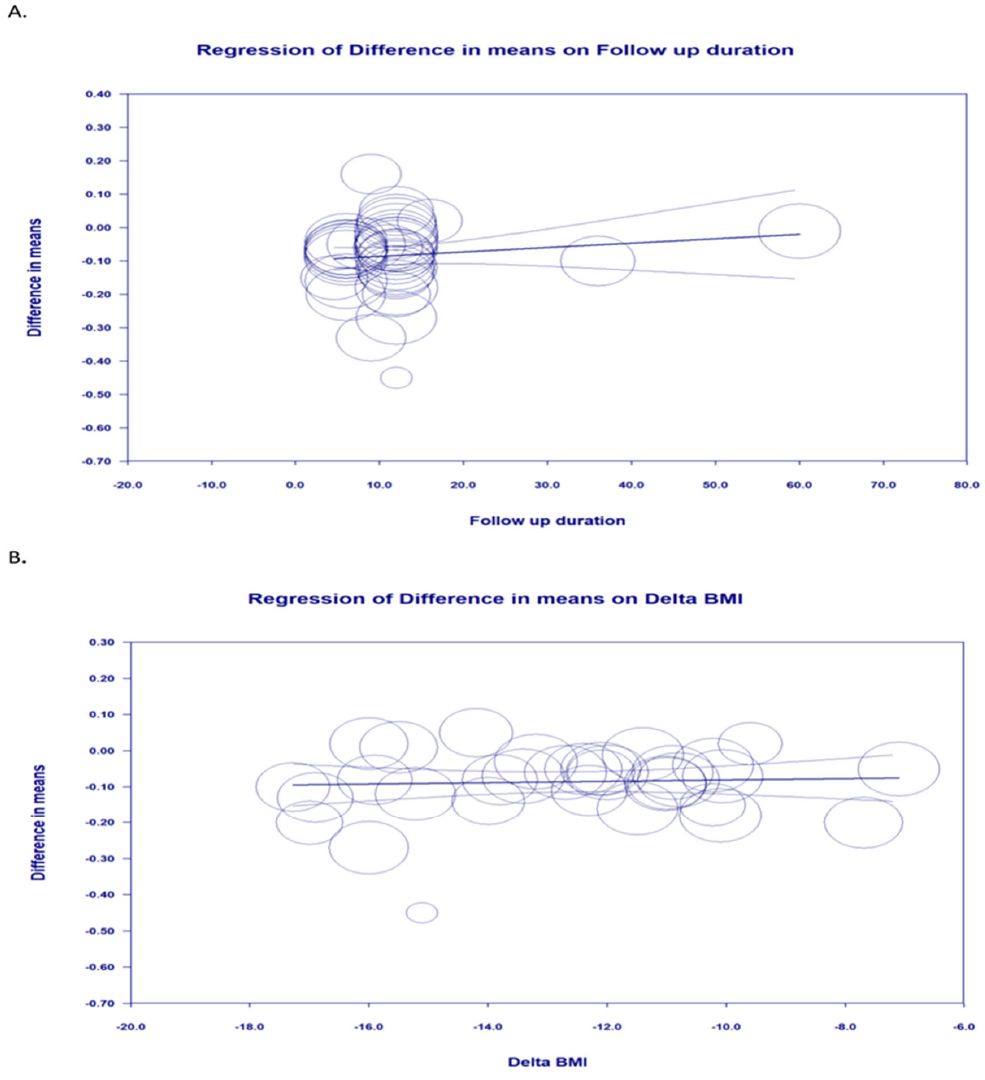
Figure 3. Random-effects meta-regression for evaluating the effect of: ( A ) delta BMI; ( B ) follow-up Figure 3. Random ‐ effects meta ‐ regression for evaluating the effect of: ( A ) delta BMI; ( B ) follow ‐ up duration.